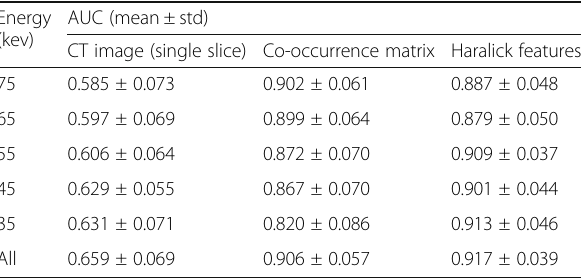
Table 4 Classification performance of raw image scheme Energy AUC (mean ± std) (kev) CT image (single slice) Co-occurrence matrix Haralick features 75 0.585 ± 0.073 0.902 ± 0.061